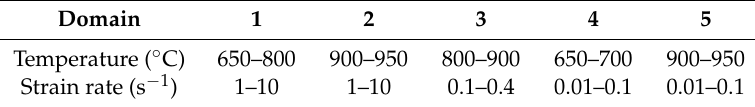
Figure 7. Labeled PMs of the Fe-6.5wt. %Si alloy at the true strain of 0.7. Table 6. Temperatures and strain rates corresponding to the five domains.